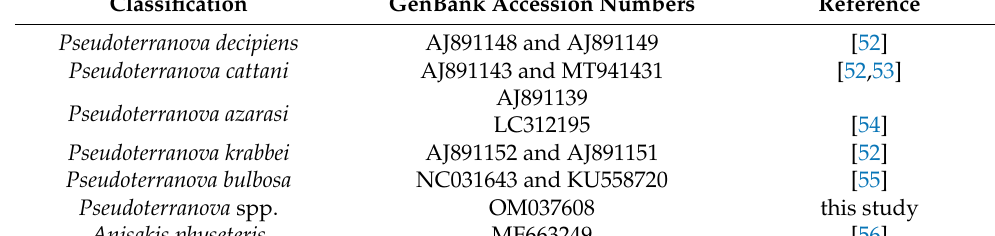
to GenBank as an outcome of the present study.